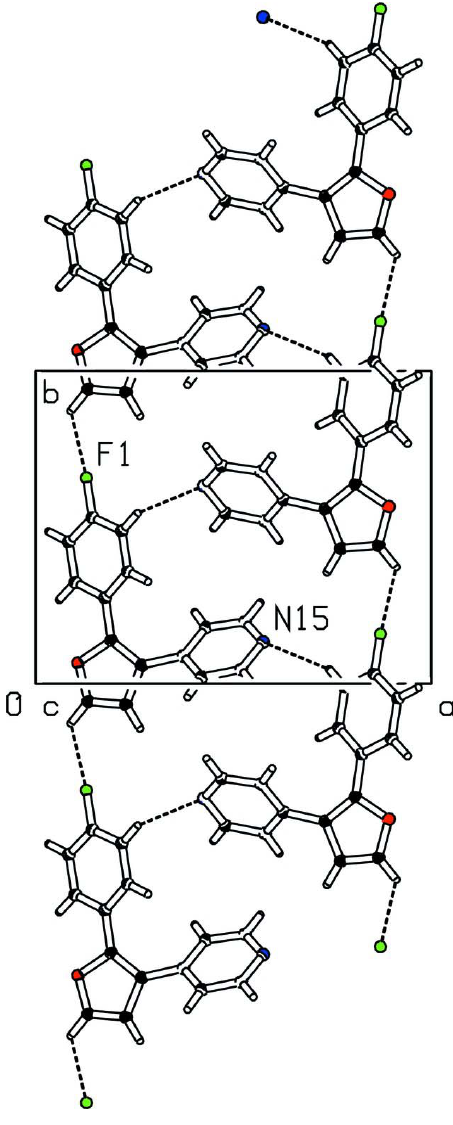
Partial crystal packing diagram of the title compound. The hydrogen bonds are shown with dashed lines. View along the c